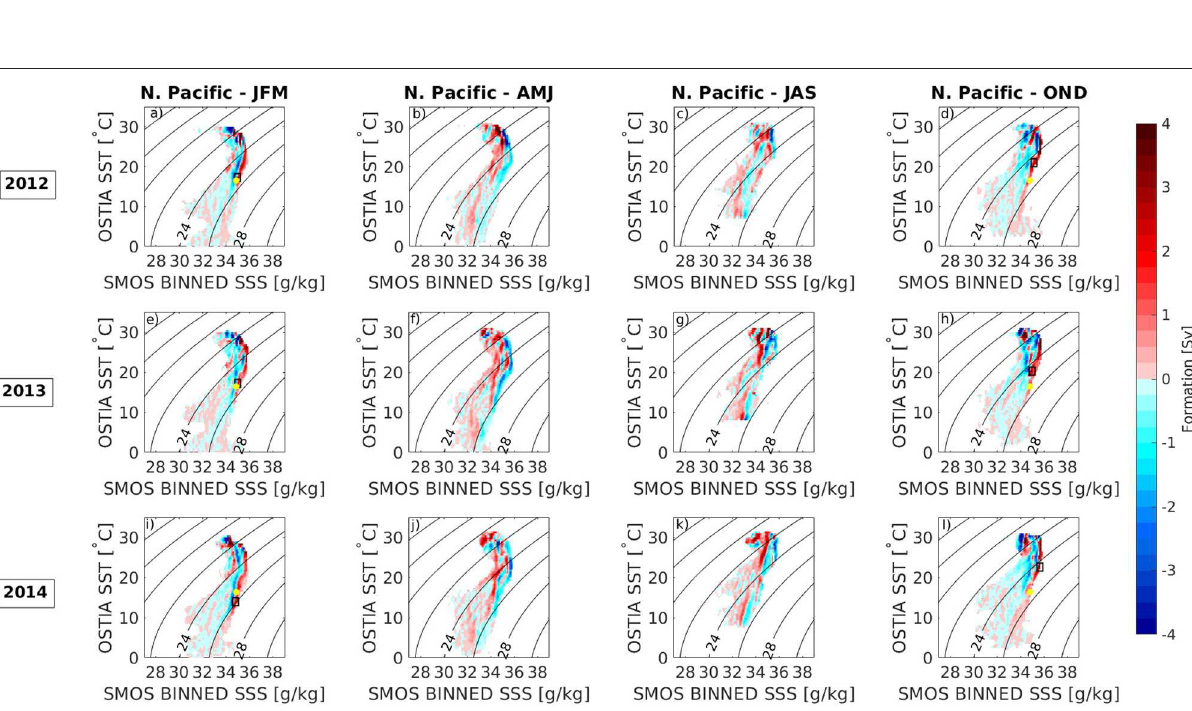
Frontiers in Marine Science | www.frontiersin.org